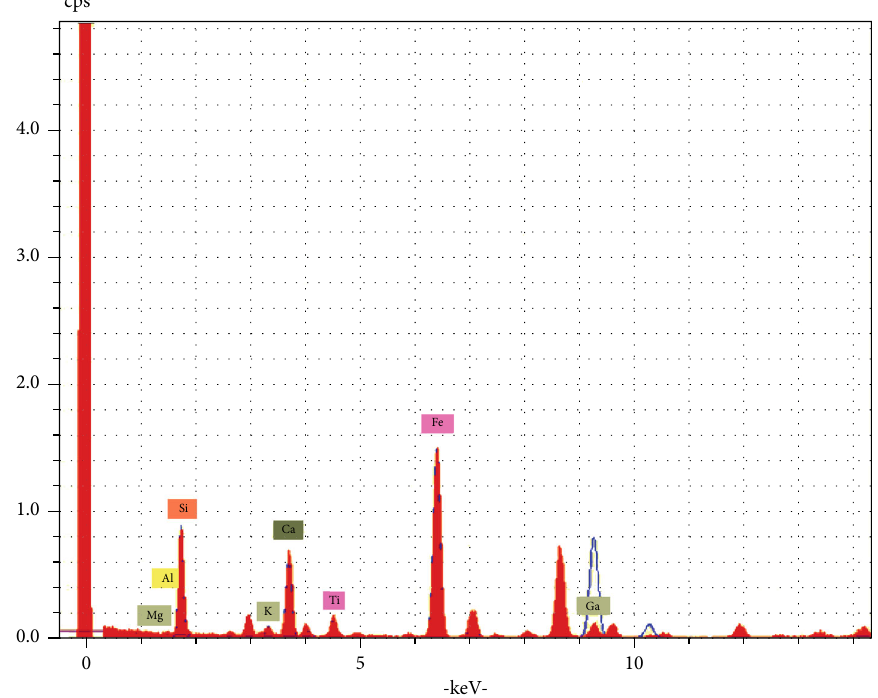
Figure 5: The components of the M-ARM were analyzed using